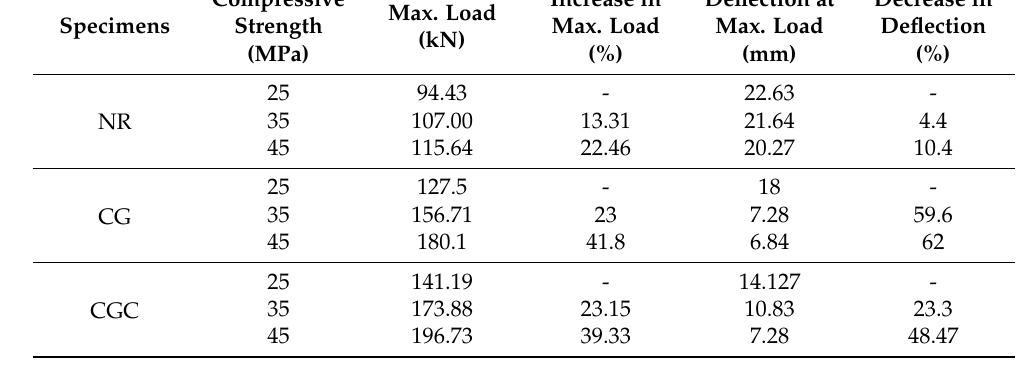
Table 10. Summary of the concrete compressive strength effects.